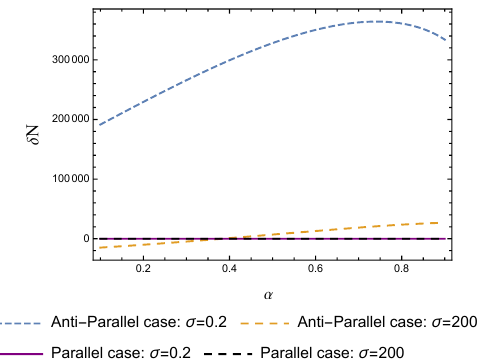
Figure 18 . Parallel and Anti-parallel motions in (1 + 1) dimensions with thermal background: δ N Vs α plot with ∆ E = 1 , A = 3 . a B